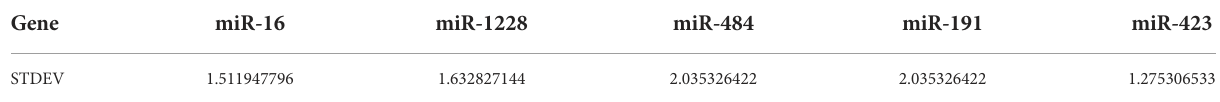
TABLE 4 Dispersion of the Ct values.